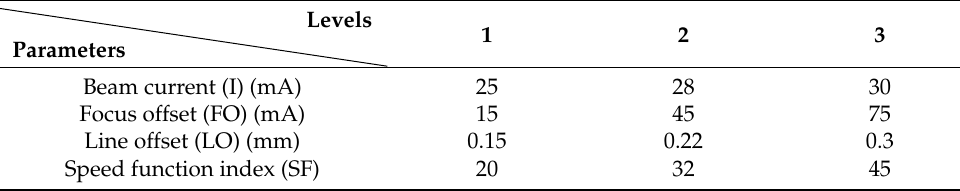
Table 1. Process parameters and their levels.